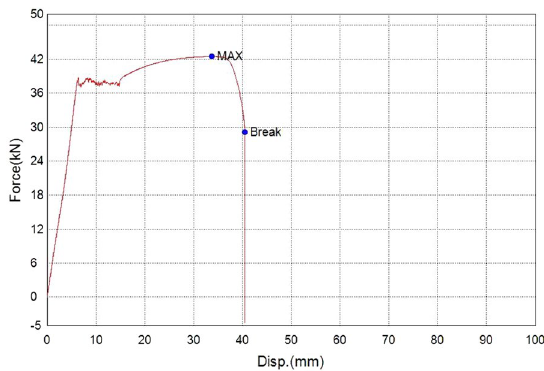
Fig. 4 Tensile test graph for H6, H12, and H16 rebars